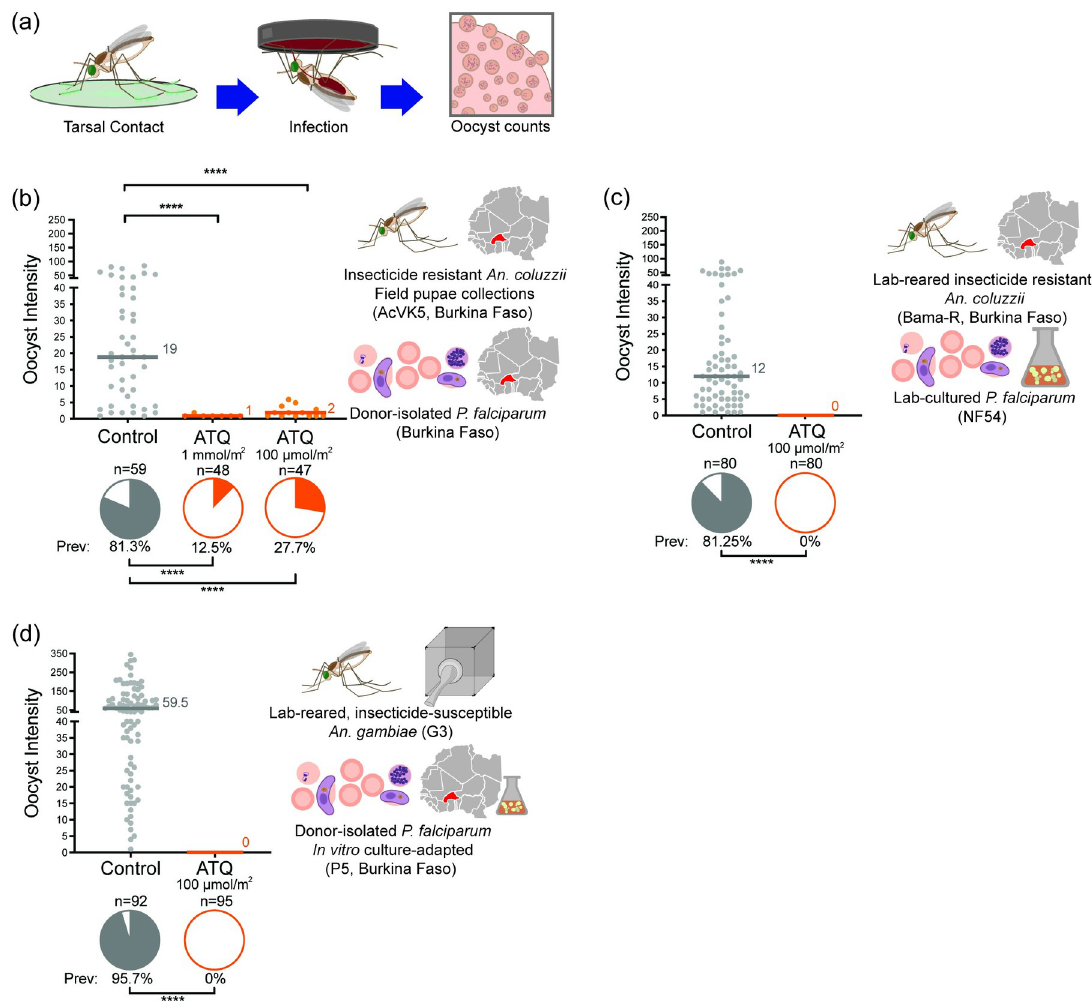
Fig 1. Exposing An . gambiae mosquitoes to ATQ suppresses P . falciparum development in field-derived parasites and insecticide- resistant mosquitoes. (a) Experimental scheme. (b) Female AcVK5 mosquitoes, collected as pupae from breeding sites in southwestern Burkina Faso, were exposed to ATQ by tarsal contact at either the maximal effective concentration (EC 99 ) for insecticide-susceptible mosquitoes (100 μ mol/m 2 , EC 99 ) or 10x EC 99 (1 mmol/m 2 ) for 6 minutes, prior to infection with donor-isolated “wild” P . falciparum (Burkina Faso), collected the same day. ATQ treatment resulted in a significant reduction in both infection prevalence (GLM (Binomial; Logit): 100 μ mol/m 2, n = 106, df = 1, Χ 2 = 31.997, p < 0.0001; 1 mmol/m 2 , n = 107, df = 1, Χ 2 = 50.240, p < 0.0001) and intensity (GLM (Poisson;Log): 100 μ mol/m 2 : n = 53, df = 1, Χ 2 = 24.687, p < 0.0001, 1 mmol/m 2 : n = 59, df = 1, Χ 2 = 31.997, p < 0.0001) at both doses, as measured by determination of P . falciparum oocyst burden at 7 d pIBM. (c) In contrast, transmission of in vitro- cultured P . falciparum (NF54) is completely blocked when field-derived, lab-adapted insecticide-resistant An . gambiae (Bama-R) are exposed to ATQ for 6 min to the maximal effective concentration (EC 99 ) for insecticide-susceptible mosquitoes (100 μ mol/m 2 ) prior to infection. In ATQ-exposed mosquitoes, prevalence was zero, in contrast to the robust infection in mock-exposed controls (Chi 2 , n = 160, df = 1, Χ 2 = 93.545, p < 0.0001). (d) Similarly, transmission of a polyclonal P . falciparum West African donor isolate (P5 – in vitro culture adapted) was blocked (zero evidence of infection at 7 d pIBM) after ATQ exposure prior an infectious blood meal, despite a strong (prevalence 95.7%, median intensity 59.5 oocysts per midgut) infection in controls (Chi 2 , n = 187, df = 1, Χ 2 = 167.995, p < 0.0001). Median lines and values are indicated, “n” indicates the number of independent samples. To isolate Oocyst Prevalence and Oocyst Intensity, midgut samples with zero oocysts have been excluded from intensity analysis. Statistical significance is indicated where relevant as follows: ns = not significant, � = p < 0.05, �� = p < 0.01, ��� = p < 0.001, ���� = p <